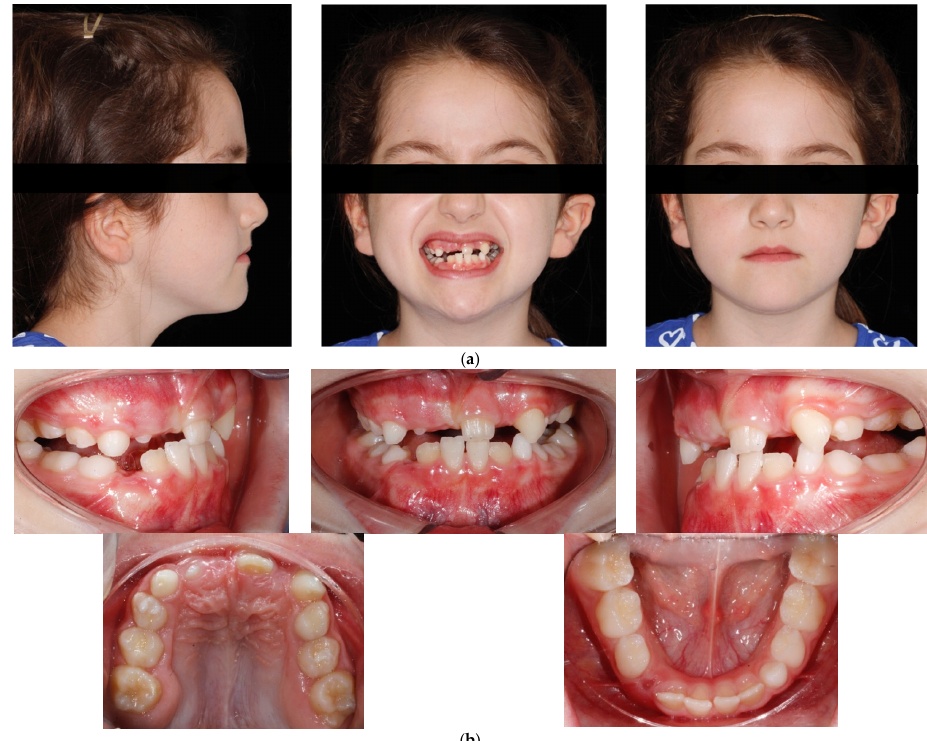
Figure 6. ( a ) Extraoral post-treatment pictures: lateral and frontal views; ( b ) Intraoral post-treatment pictures: lateral and frontal views; occlusal views: upper and lower arches. Children 2022 , 9 , x FOR PEER REVIEW The reaction of the craniofacial complex to orthopaedic treatment with the Class III PowerScope protocol consisted of significant changes in maxillary growth direction and position with an increase in SNA and ANB and favourable decrease in SNB. A post-treat- ment lateral cephalograph revealed an angular and linear sagittal measurement of the mandible with significant improvements during active treatment, respectively, of 0.6° and 1.2 mm (Figure 7).